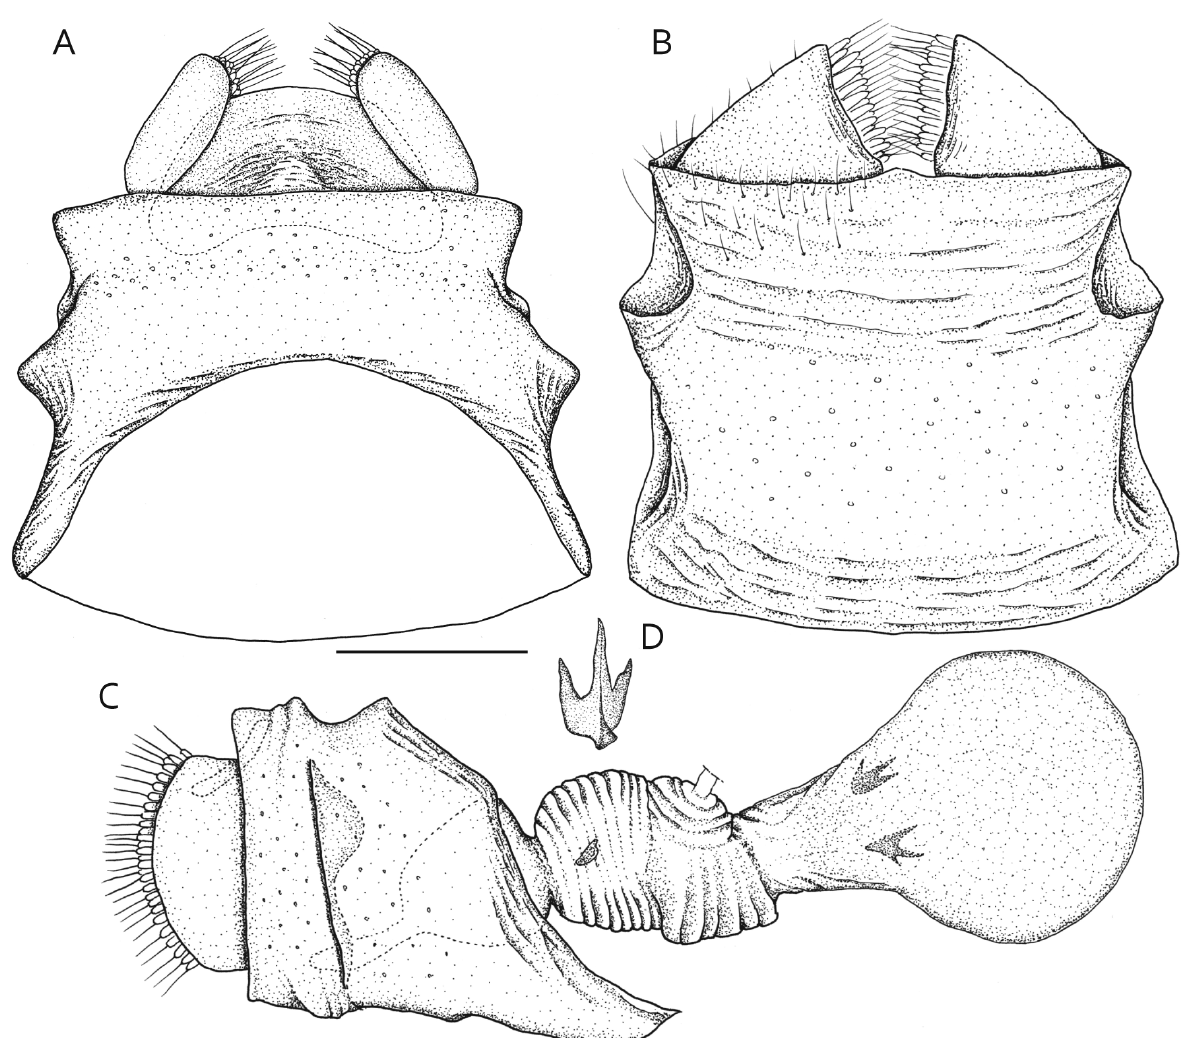
Figure 11. Female genitalia of Issikiomartyria leptobelos sp. n. [paratype]. A: genitalia capsule, dorsal view; B: ditto, ventral view; C: female genitalia, lateral view; D: signa. Scale bars: 0.2 mm.